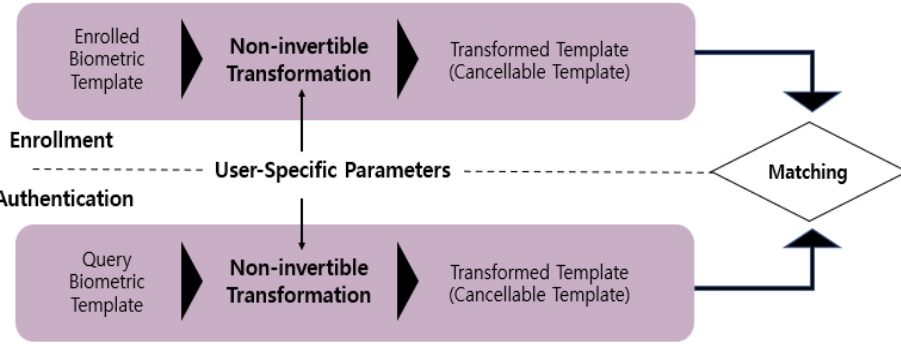
Figure 1. Illustration of a general cancelable biometrics scheme.